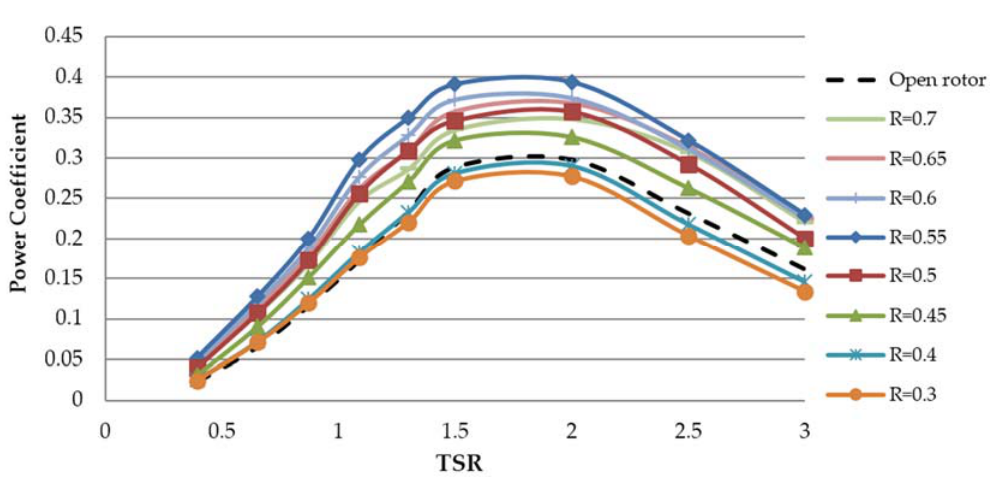
Figure 29. Power coefficient versus TSR for open and augmented rotors.